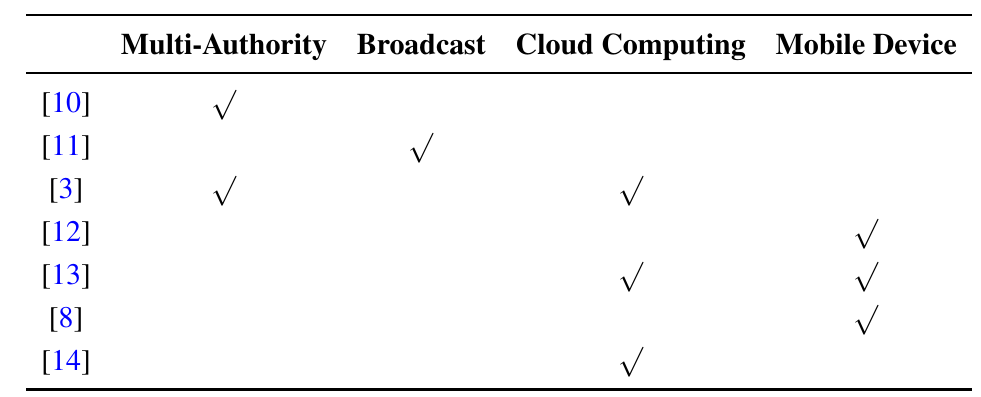
Table 1. Comparison of related